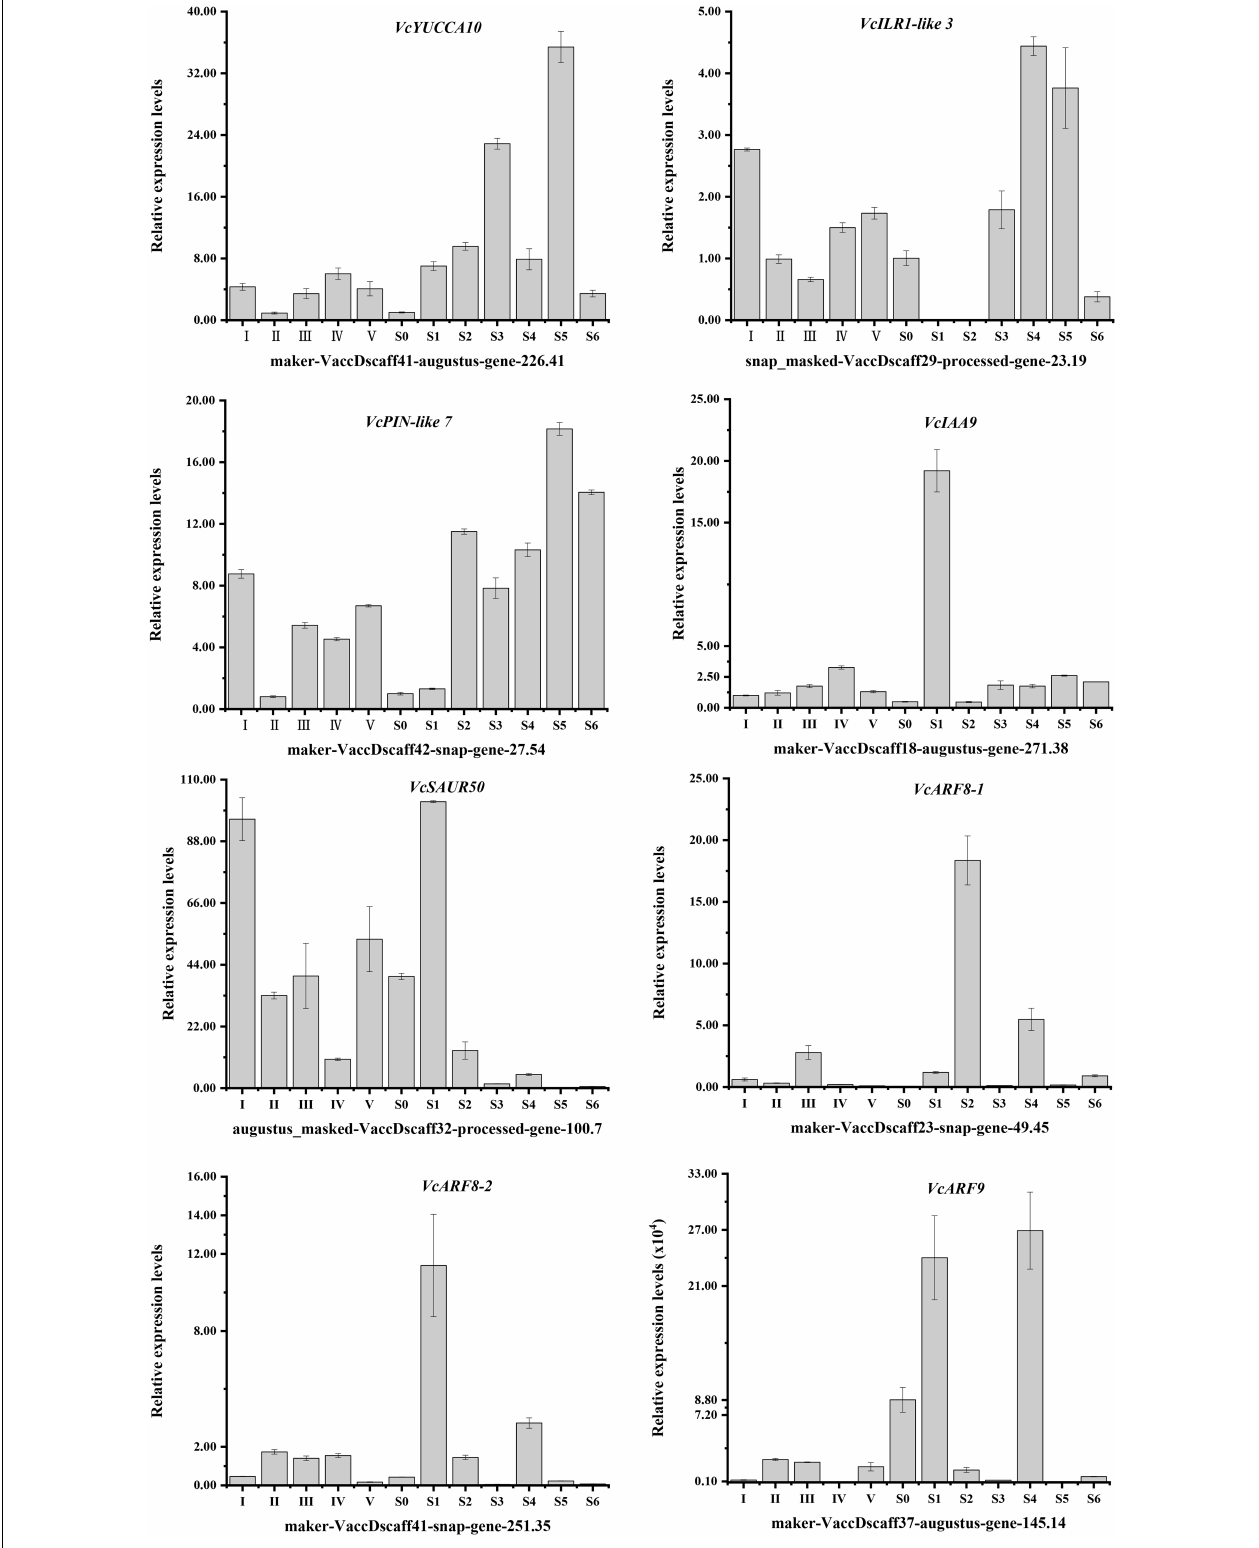
FIGURE 5 | Expression patterns of specific auxin-related DEGs throughout V. corymbosum ‘O’Neal’ flower bud and fruit development.